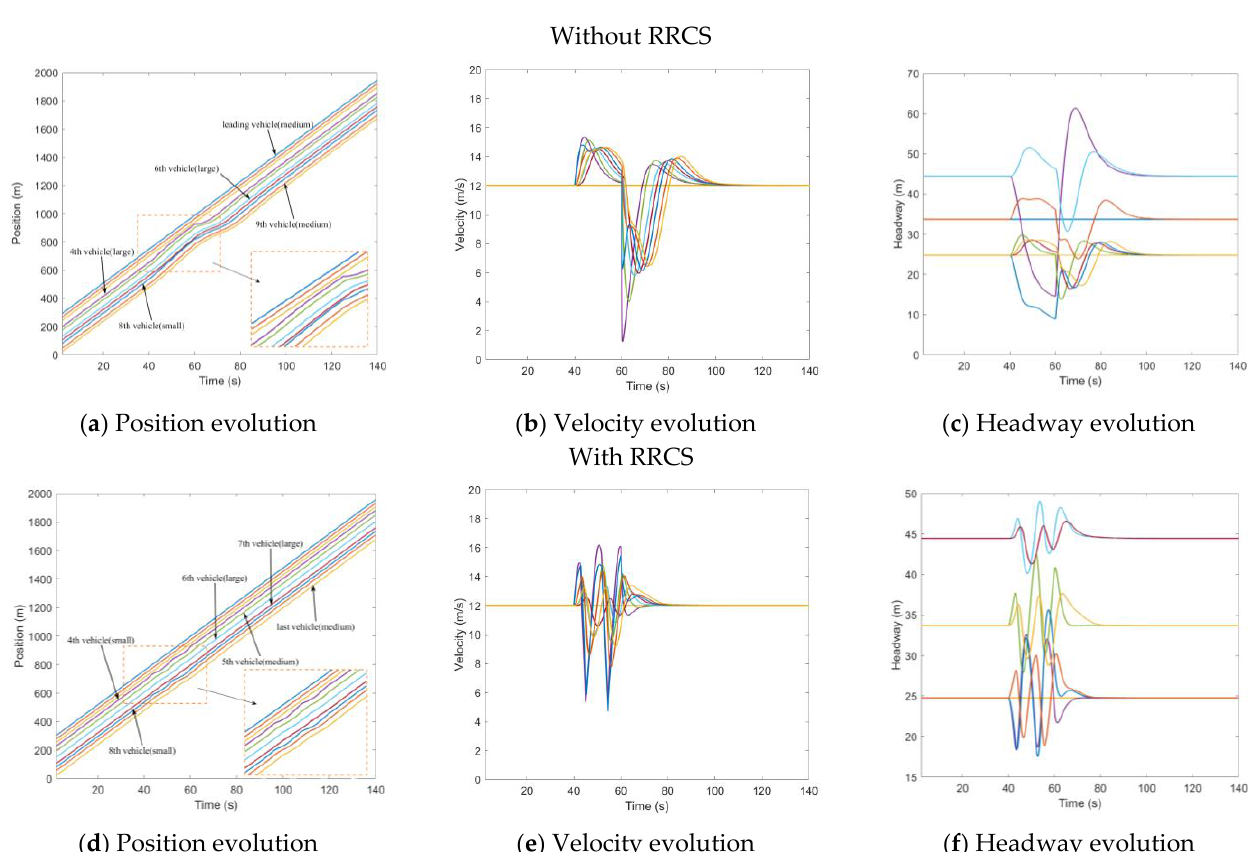
Figure 9. Mixed traffic flow evolution diagrams under collusion attacks (Type II) with/without RRCS.